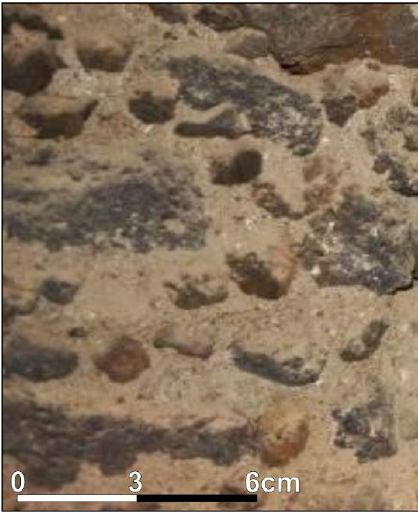
Figure 2. Masonry of the bell tower: photo of the internal side.